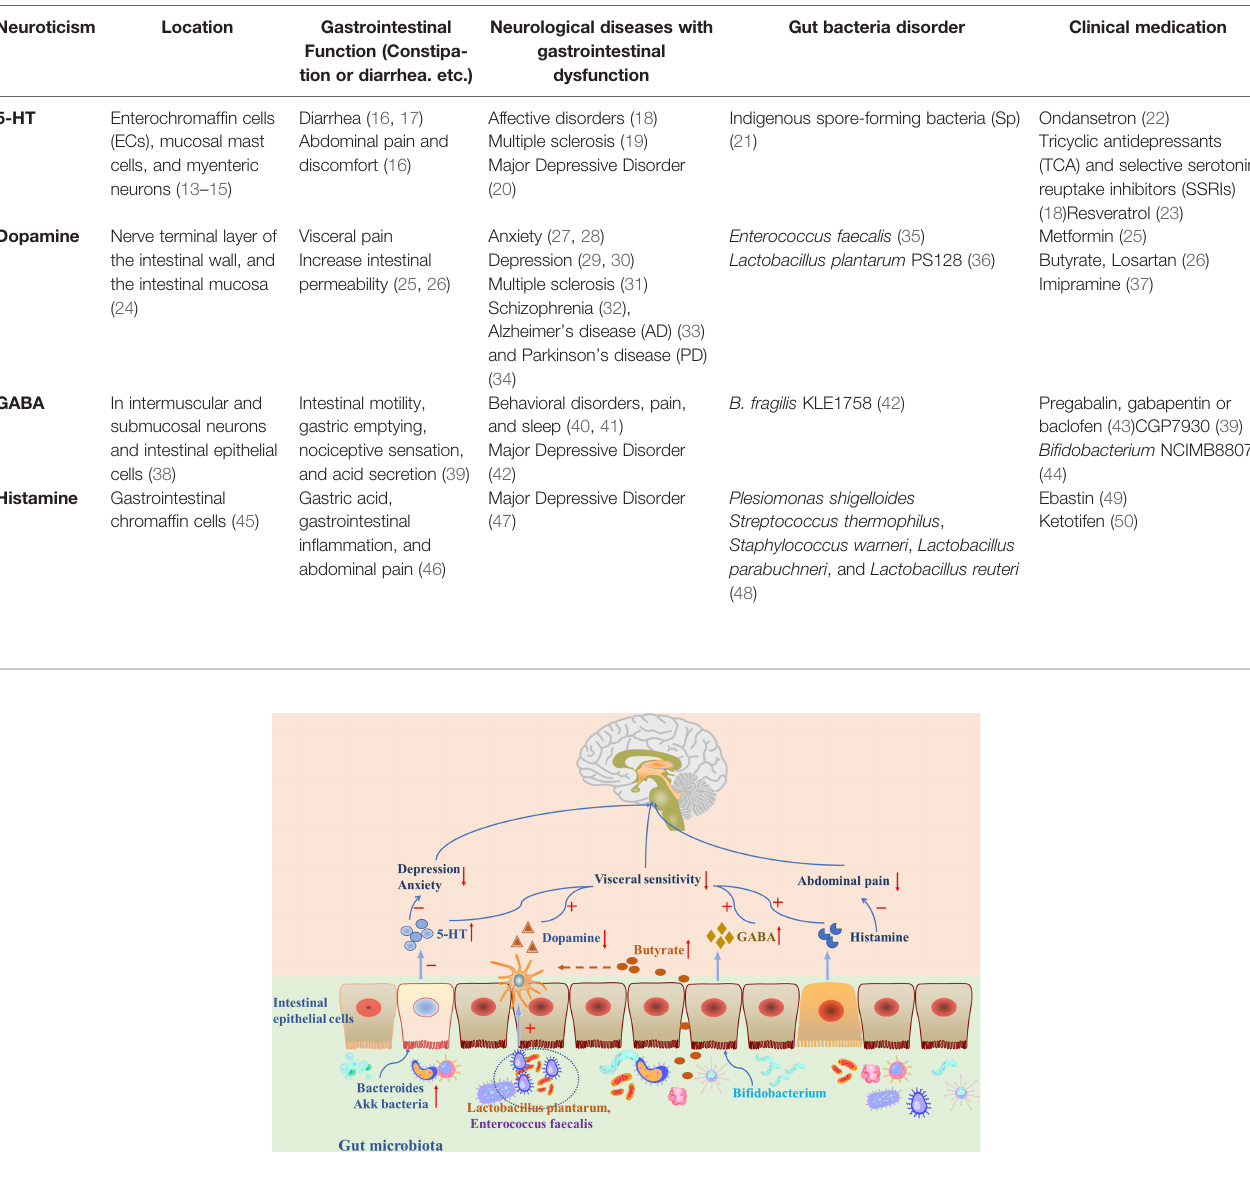
TABLE 1 | Research on neurological disorders and the microbiota-gut-brain axis.